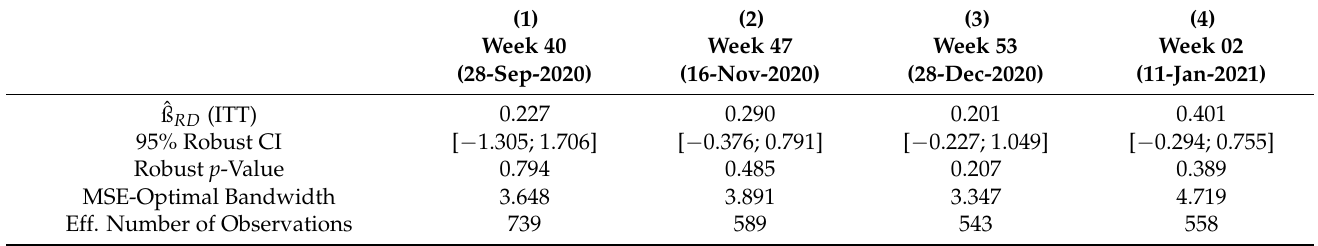
Table 3. RD effect with placebo